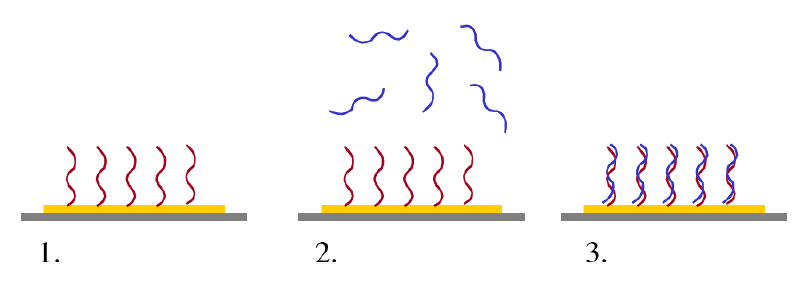
A general strategy for electrochemical DNA detection begins with immobilization of a ssDNA capture probe on an electrode surface: (1) After probe immobilization, baseline electrical measurements are taken and then target DNA is added; (2) Target DNA is allowed to hybridize with the capture DNA; (3) Another set of electrical measurements are made to detect the electrode changes caused by DNA